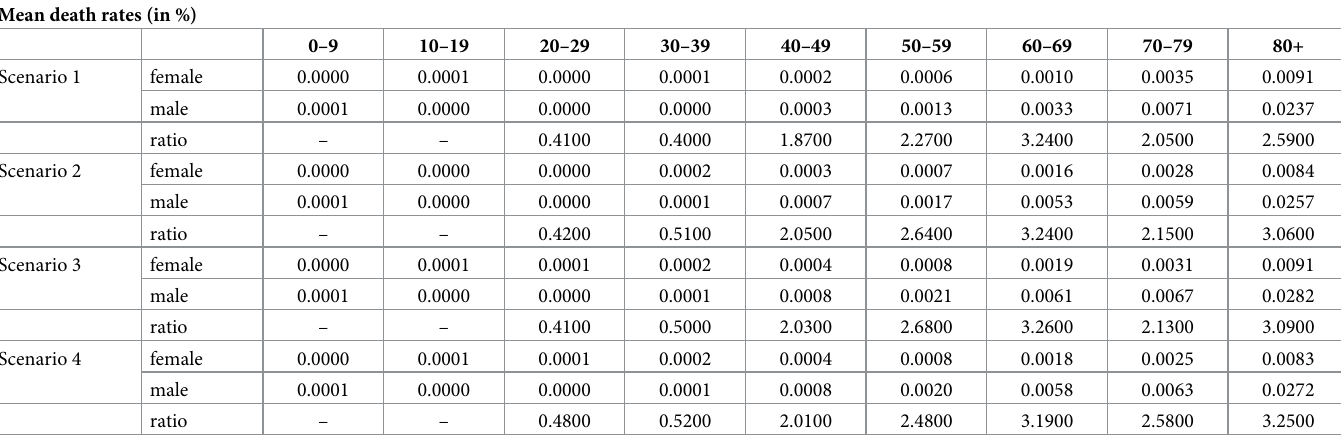
Table 3. Mean death rates (in %) and male/female